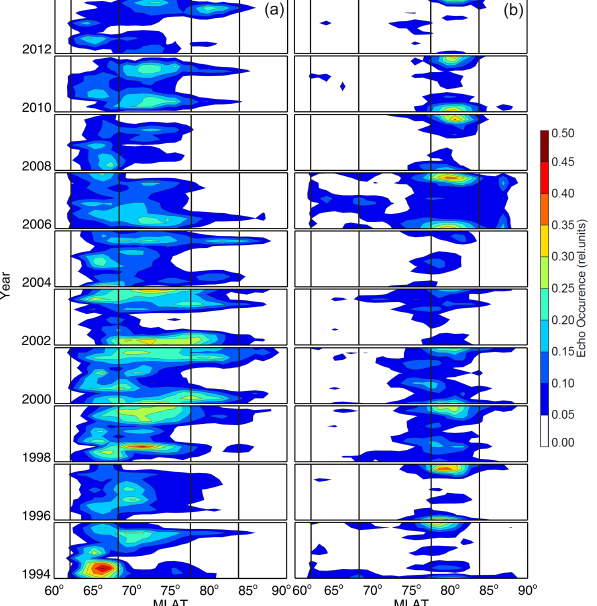
Fig. 2. Saskatoon SuperDARN radar echo occurrence rates at all available magnetic latitudes in the dusk sector (17:00–19:00MLT) and noon (11:00–13:00MLT) for the even years in the period of 1994–2012.